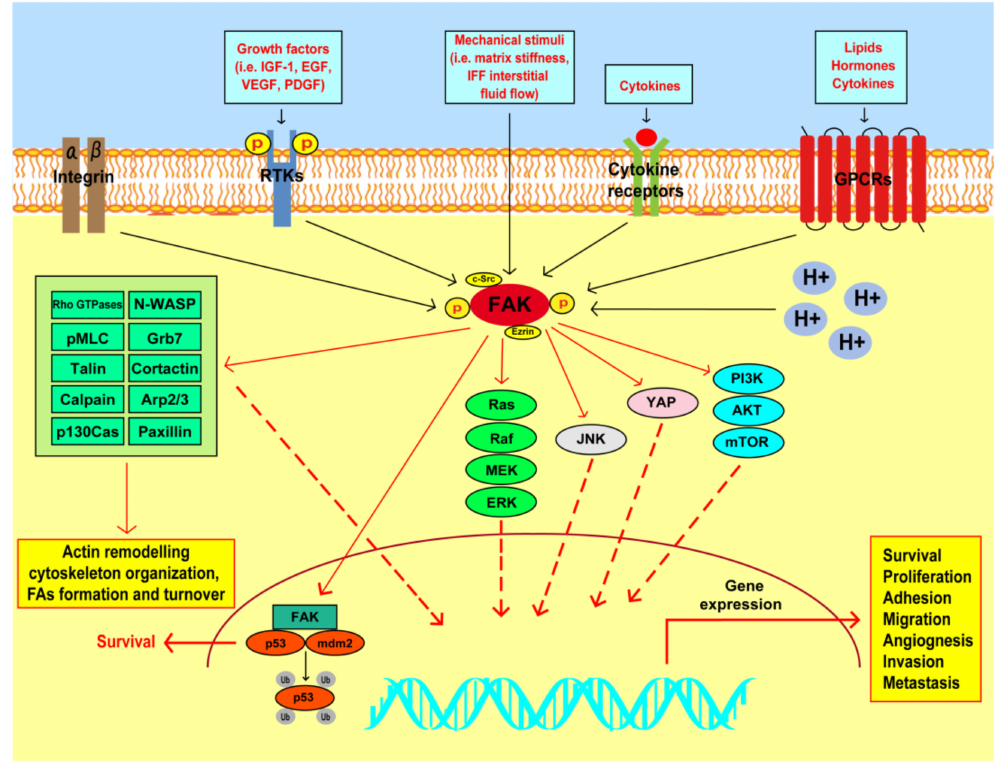
Figure 2. FAK-mediated transduction pathways implicated in breast tumor progression. FAK may be activated by integrins, receptor tyrosine kinases (RTKs), mechanical stimuli, cytokine and G-protein coupled receptors (GPCRs) and changes of intracellular pH (H+). Active FAK may interact with adaptor molecules, such as Src and ezrin, and enhance actin remodeling, cytoskeleton organization, formation and turnover of focal adhesions (FAs) interacting with or activating Rho-GTPases, N-WASP, pMLC, Grb7, talin, cortactin, calpain, Arp2/3, p130Cas and paxillin. Upon phosphorylation, FAK may trigger the activation of diverse transduction pathways like Ras/Raf/MAPK/ERK, JNK, YAP and PI3K/AKT/mTOR signaling, which in turn regulate the expression of genes implicated in the stimulation of malignant features of breast cancer cells, as indicated. Acting also as a nuclear scaffold for p53 and mdm2, FAK may promote p53 polyubiquitination (Ub) and degradation, thus facilitating cancer cell survival. Solid black lines indicate well known FAK activators. Solid red lines indicate the proposed signaling pathways activated by FAK and the FAK nuclear interaction with the p53/mdm2 complex. Dashed red lines indicate the main actions triggered by the molecular mediators activated by FAK toward the upregulation of genes involved in diverse protumorigenic